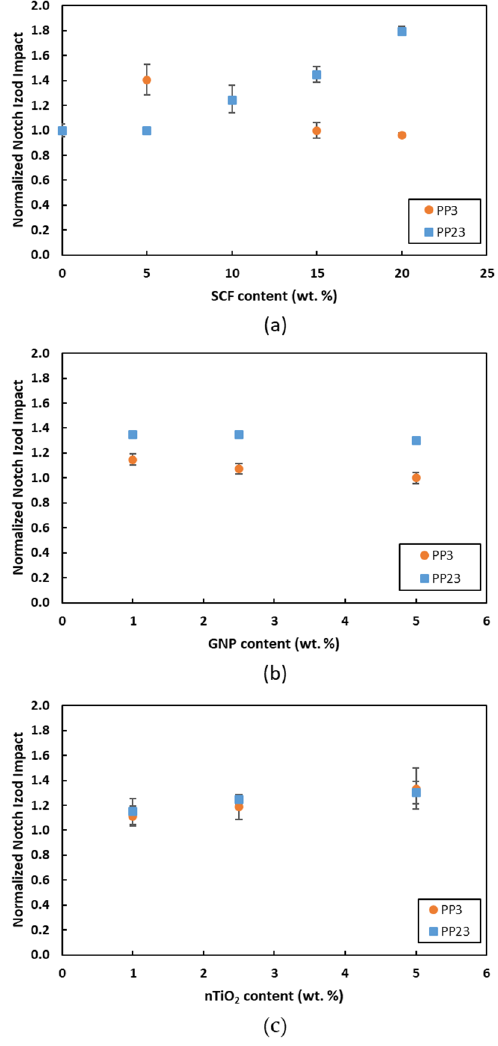
Figure 15. Normalized notch Izod impact toughness of ( a ) PP/SCF, ( b ) PP/GNP, and ( c ) PP/nTiO 2 composites.